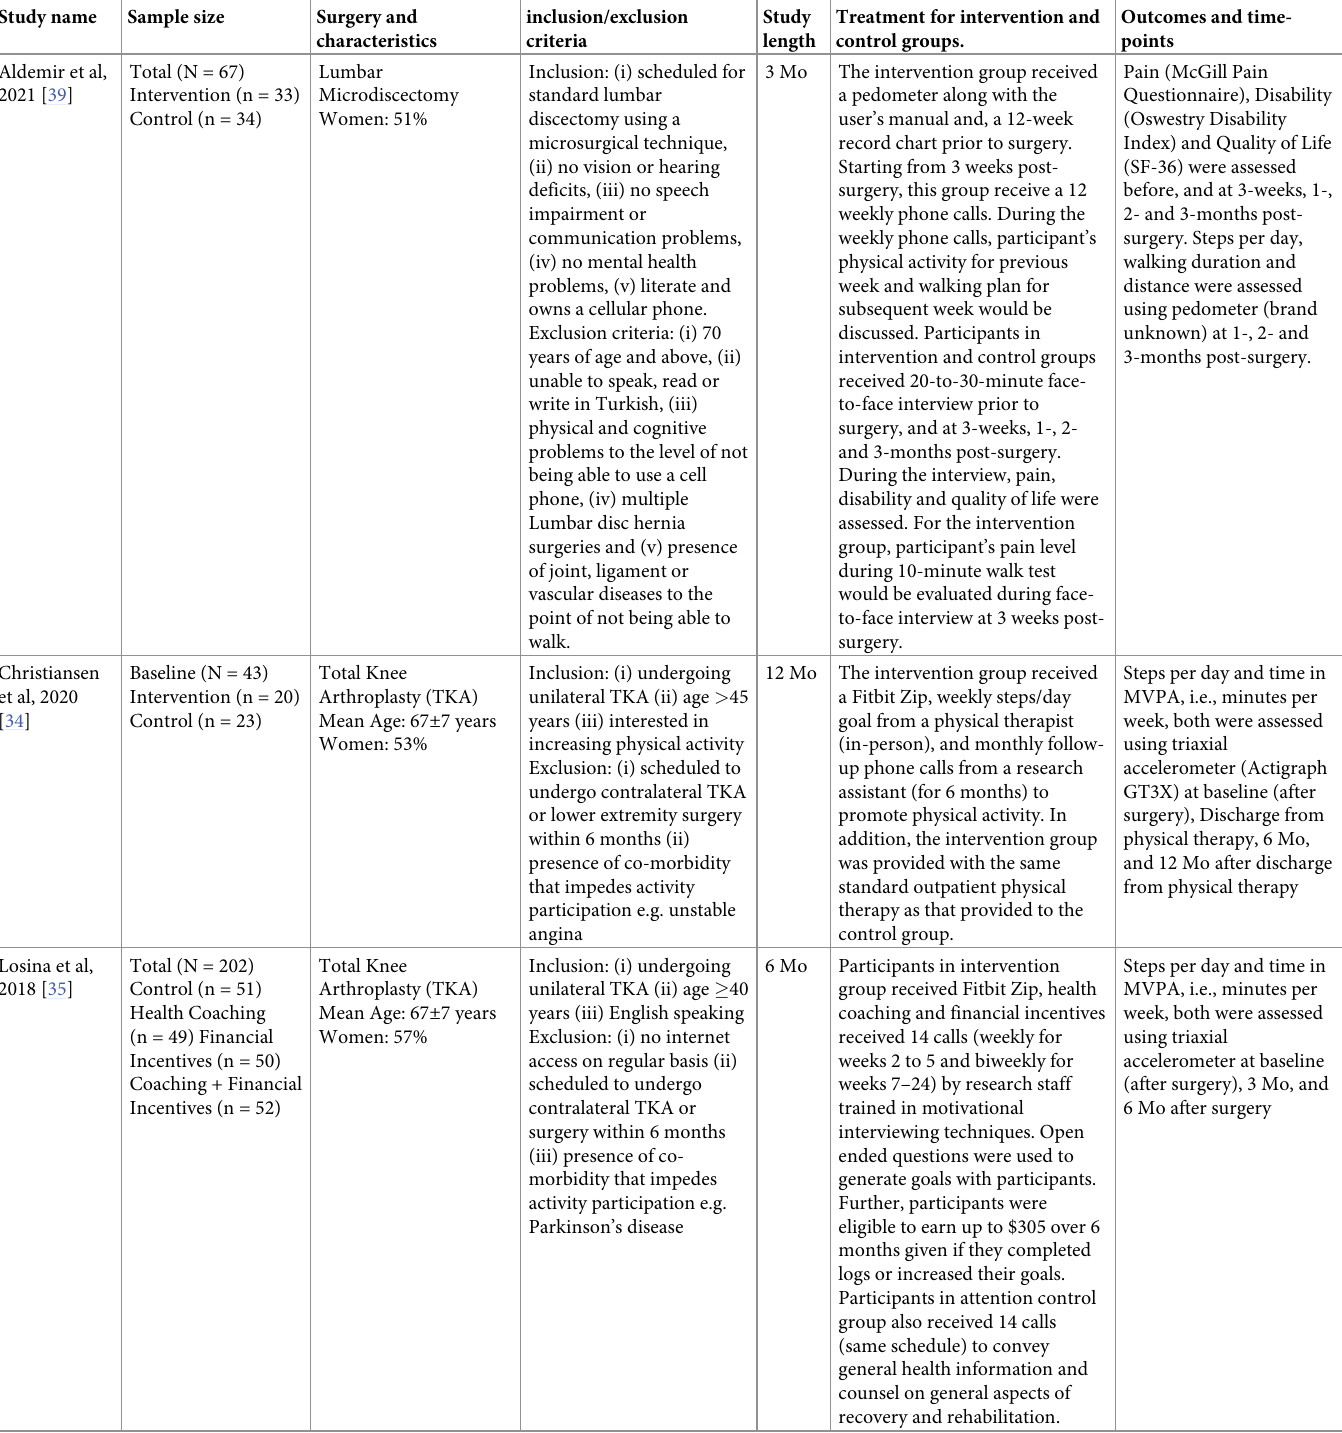
Table 1. Articles included in systematic